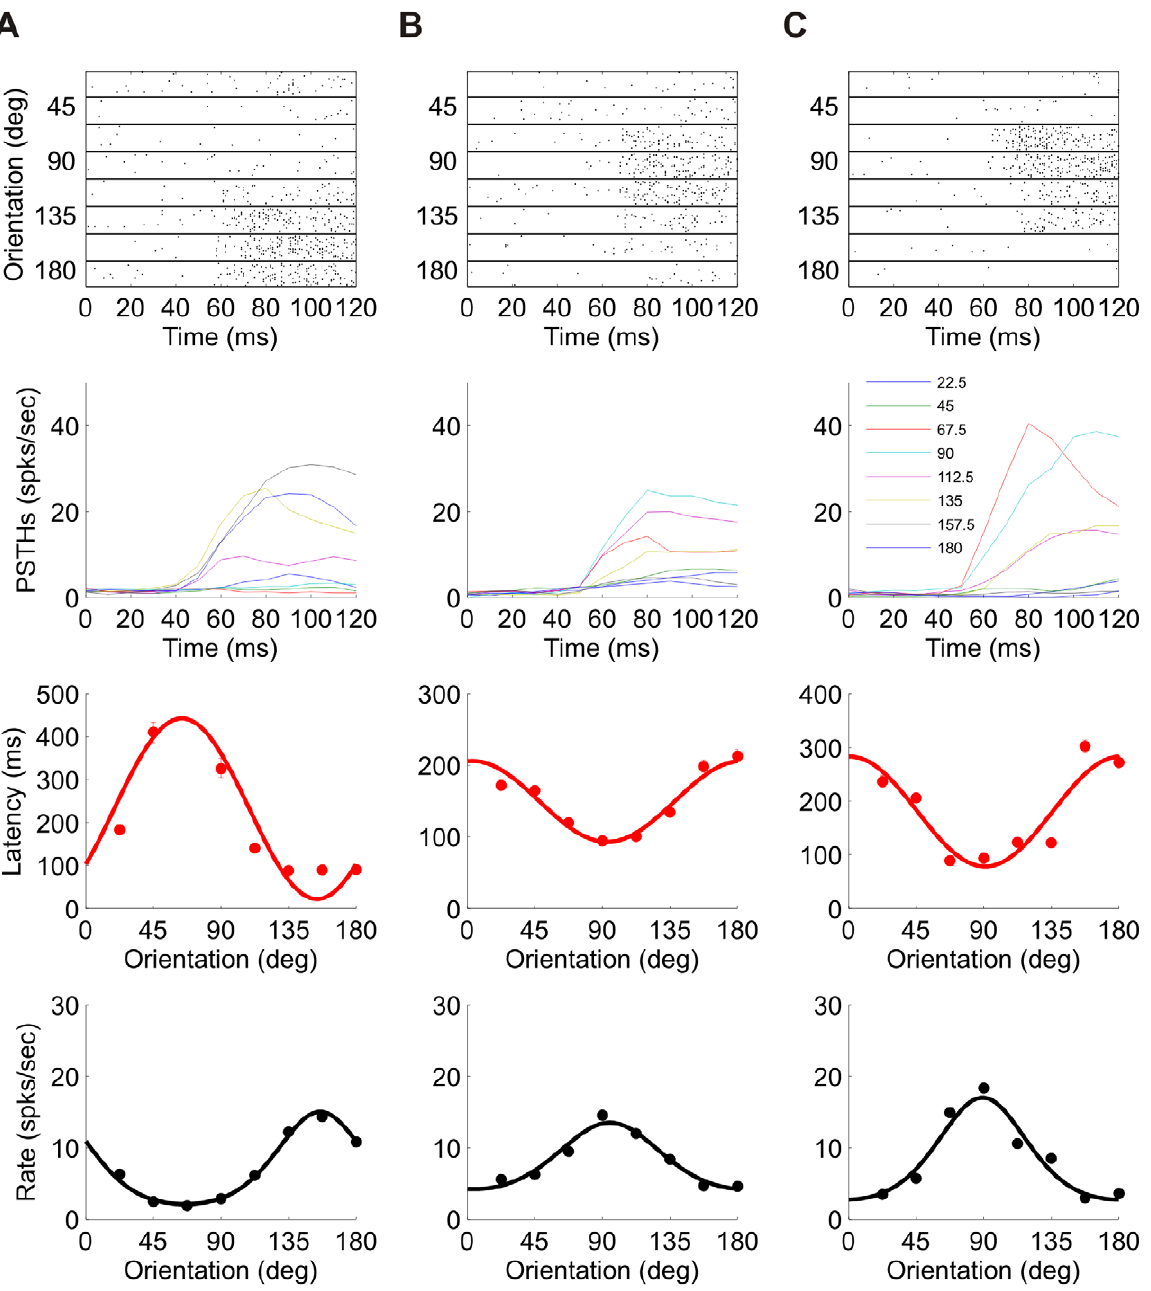
Figure 2. Additional examples of spike latency tuning. Each column, (A)–(C), corresponds to data from a different unit. First row: Raster plot for each of the 8 orientations. For each orientation, 100 randomly chosen trials are shown for 120 ms after stimulus onset. Second row: PSTH (Post Stimulus Time Histogram) for the same time window. Third row: Tuning curve of first spike latency. Cosine fit is shown as a solid line. Fourth row: Rate tuning curve (black circles) and a fitted von-Mises function (solid line). The cell in (A) is taken from dataset 1 in Table 1, in which stimulus duration was 400 ms and the number of trials was 400. The cells in (B) and (C) are taken from dataset 5 in Table 1, in which stimulus duration was 300 ms and the number of trials was 300. These are the same 3 cells as in Figure